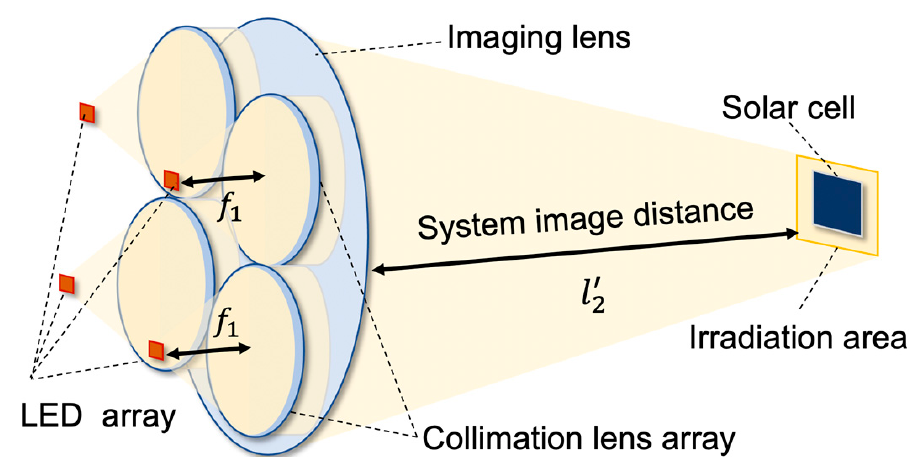
Figure 1. Collimation scheme of LED-array OWPT.